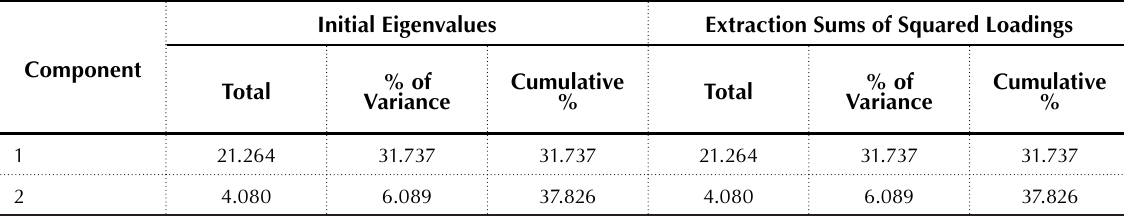
Table 4. Total variance explained